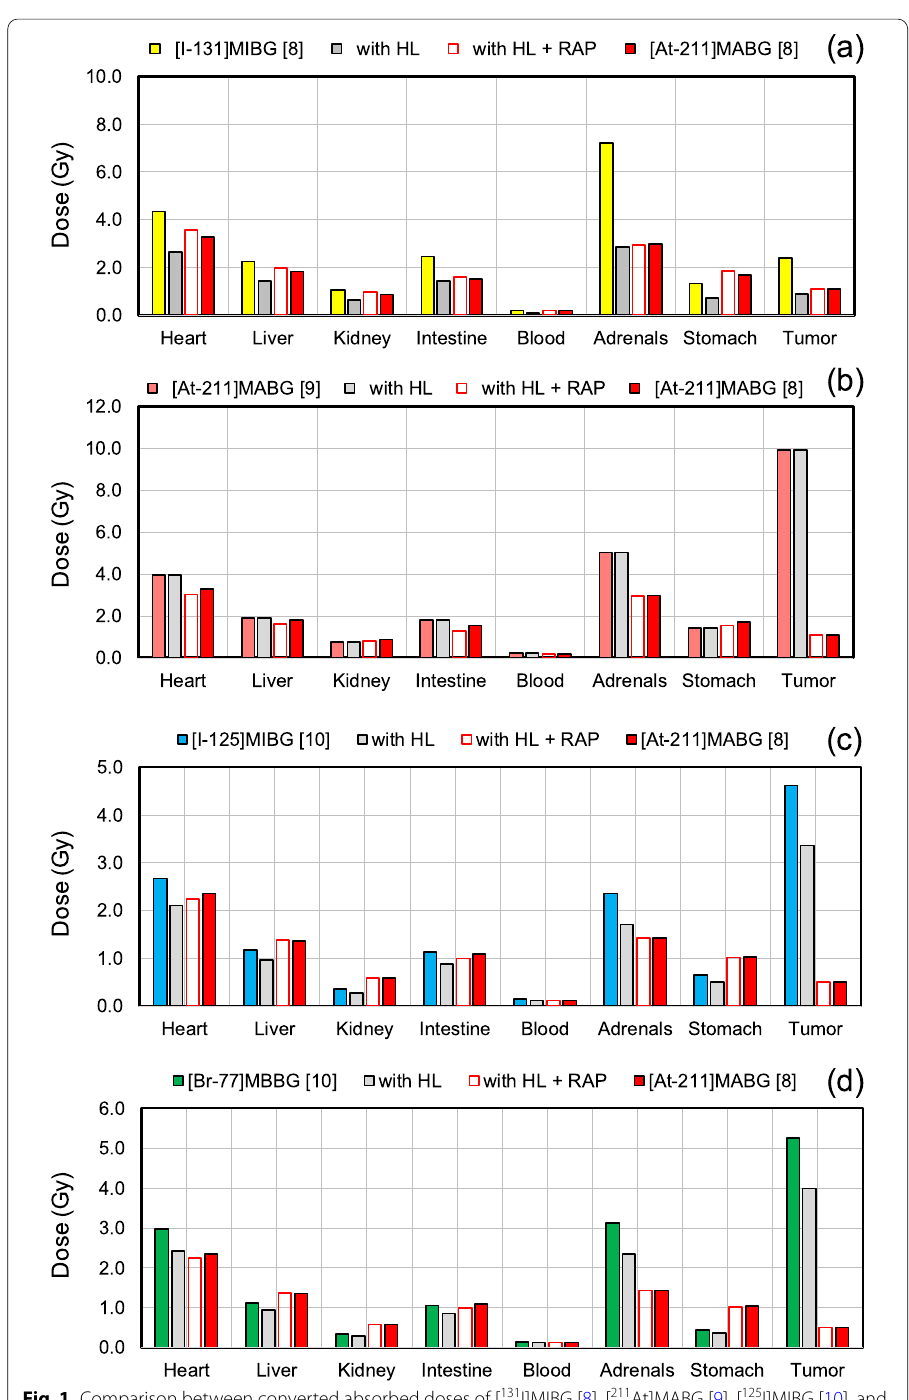
Fig. 1 Comparison between converted absorbed doses of [ 131 I]MIBG [8], [ 211 At]MABG [9], [ 125 I]MIBG [10], and [ 77 Br]MBBG [10] and the true target absorbed dose of [ 211 At]MABG [8]. a Converted absorbed doses from [ 131 I] MIBG [8] as a reference, and absorbed dose of [ 211 At]MABG [8] as a true target. [ 131 I]MIBG [8] indicates the absorbed dose of an organ or tumor tissue when alpha rays derived from 211 At were emitted by the number of radioactive decays of 131 I. “with half-life (HL)” shows a converted absorbed dose of [ 131 I]MIBG [8] corrected by the physical half-life of 211 At, indicating the physical part of Eq. (5).“with HL RAtio of Pharmacokinetics + (RAP)” is an absorbed dose of “with HL” converted using the representative RAP coefficient. b Same as ( a ) except that [ 211 At] MABG [9] is a reference. c Same as ( a ) except that [ 125 I]MIBG [10] is a reference. d Same as ( a ) except that [ 77 Br]MBBG [10] is a